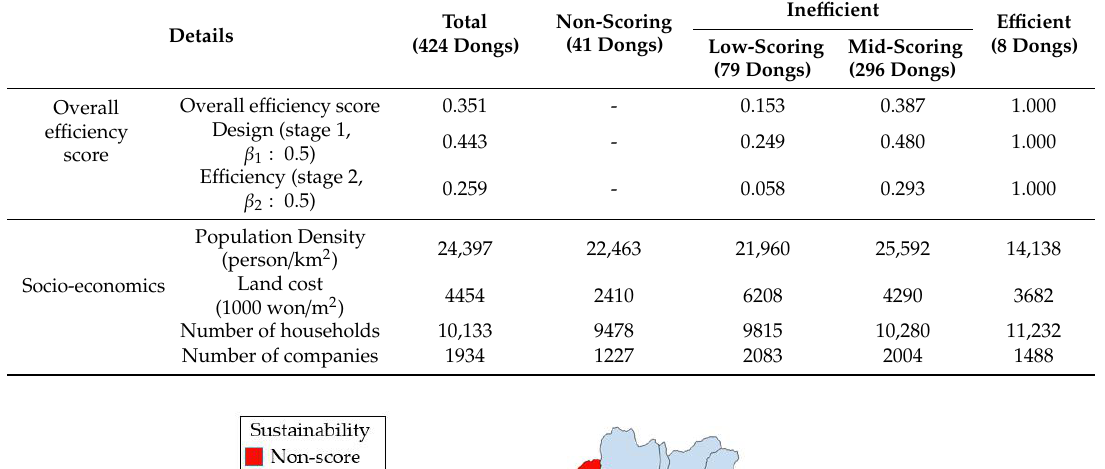
Table 5. Results of overall efficiency by Dong unit in Seoul.